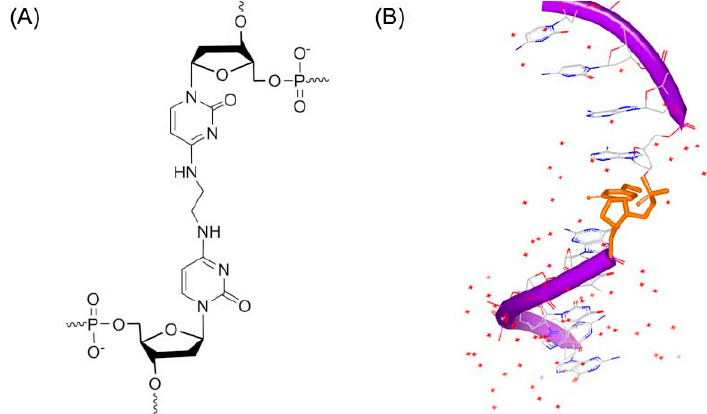
Figure 3. ( A ) Chemical structure of N 4 C–ethyl–N 4 C adduct; and ( B ) one strand of NMR structure of